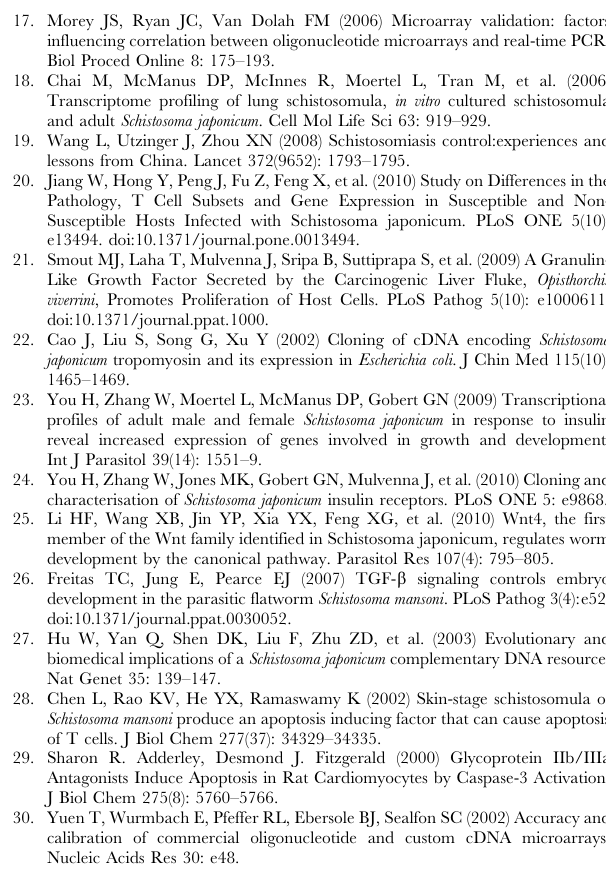
Table S1 A full list of genes, including systematic name, Gene ID and protein homology, up regulated in schistosomula from M.fortis 2 Fold change refers to expression relative to those of schistosomula from BALB/c mice. Table S2 A full list of genes, including systematic name, Gene ID and protein homology, up regulated in schistosomula from M.fortis 0.5 Fold ratio refers to expression relative to those of schistosomula from BALB/c mice. Table S3 KEGG analysis of differentially expressed genes in the schistosomula from Microtus fortis compared with those from BALB/c mice. Table S4 Information on the primers used for validation of the microarray data by quantitative qPCR analysis. Table S5 Information on the primers used for validation of the microarray data by quantitative qPCR analysis.